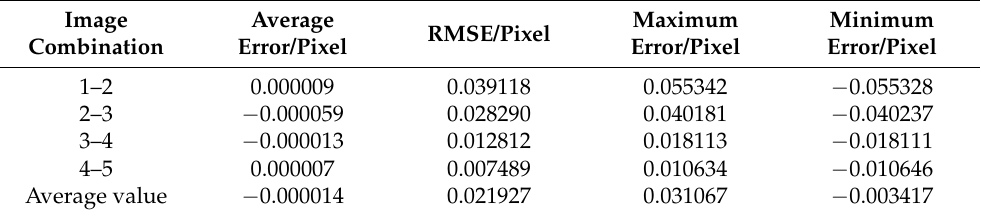
Table 5. Accuracy evaluation results of jitter modeling at 100 Hz by single disparity map.